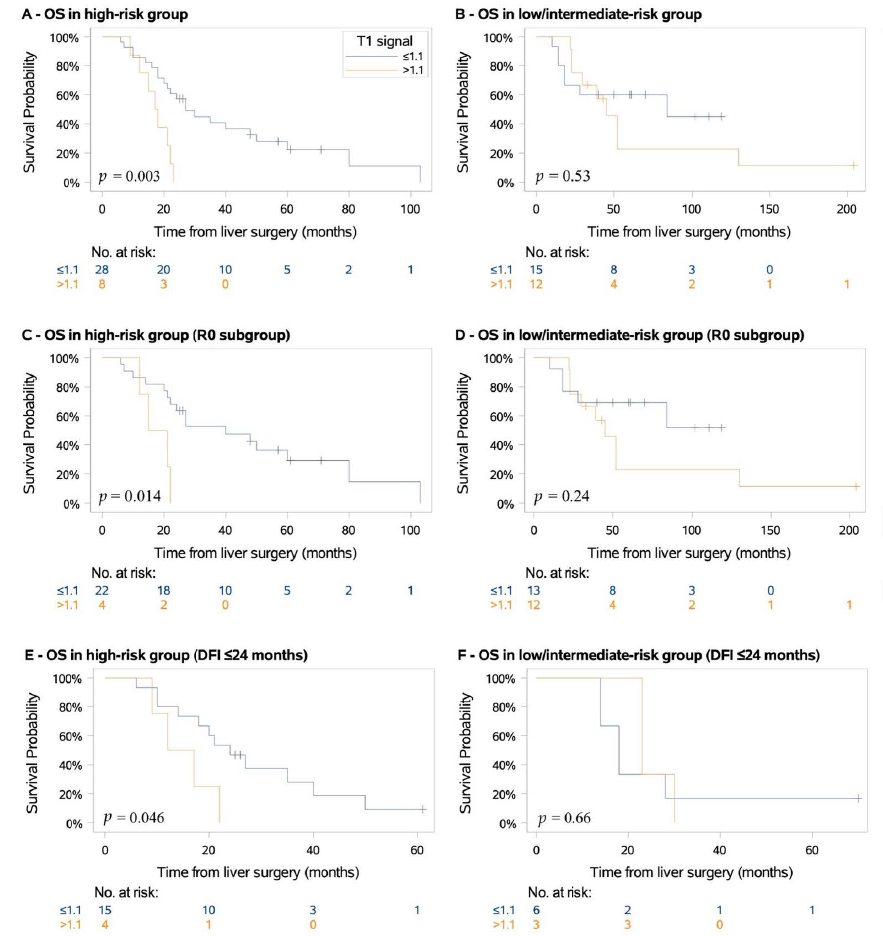
Figure 2. Overall survival (OS) of patients with metastatic hepatic uveal melanoma. p values were calculated using log-rank test. R0, complete hepatic resection; DFI, disease-free interval. ( A ) overall survival in high-genetic-risk group, ( B ) overall survival in low/intermediate-genetic-risk group, ( C ) overall survival in high-genetic-risk group with complete hepatic resection (R0), ( D ) overall survival in low/intermediate-genetic-risk group with complete hepatic resection (R0), ( E ) overall survival in high-genetic-risk group with disease-free-interval ≤ 24 months, ( F ) overall survival in low/intermediate-genetic-risk group with disease-free-interval ≤ 24 months.